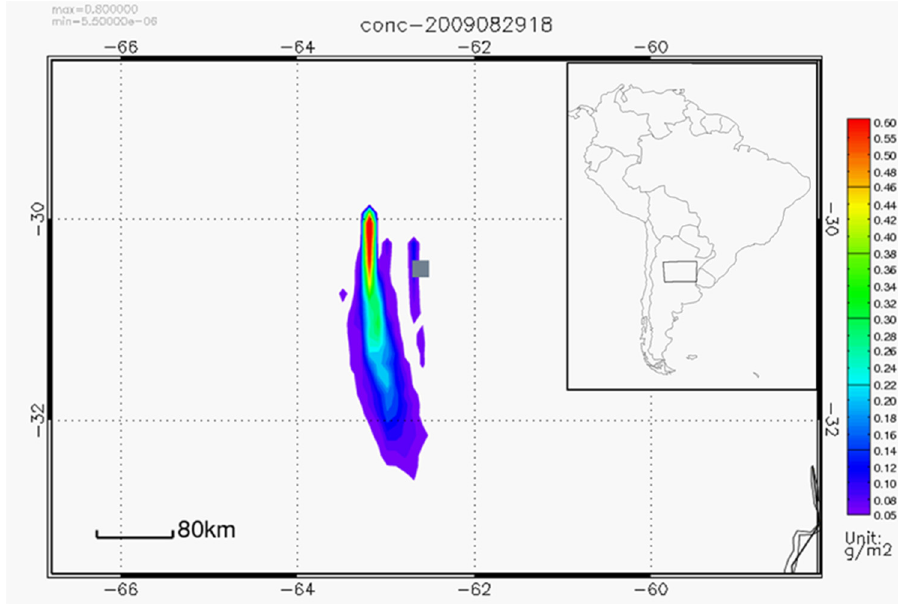
Fig 9. Simulated salt dust integrated column [g m -2 ] generated in Mar Chiquita on August 29, 2009 at 18:00 UTC. The grey square represents the location of center of the Mar Chiquita Lake.